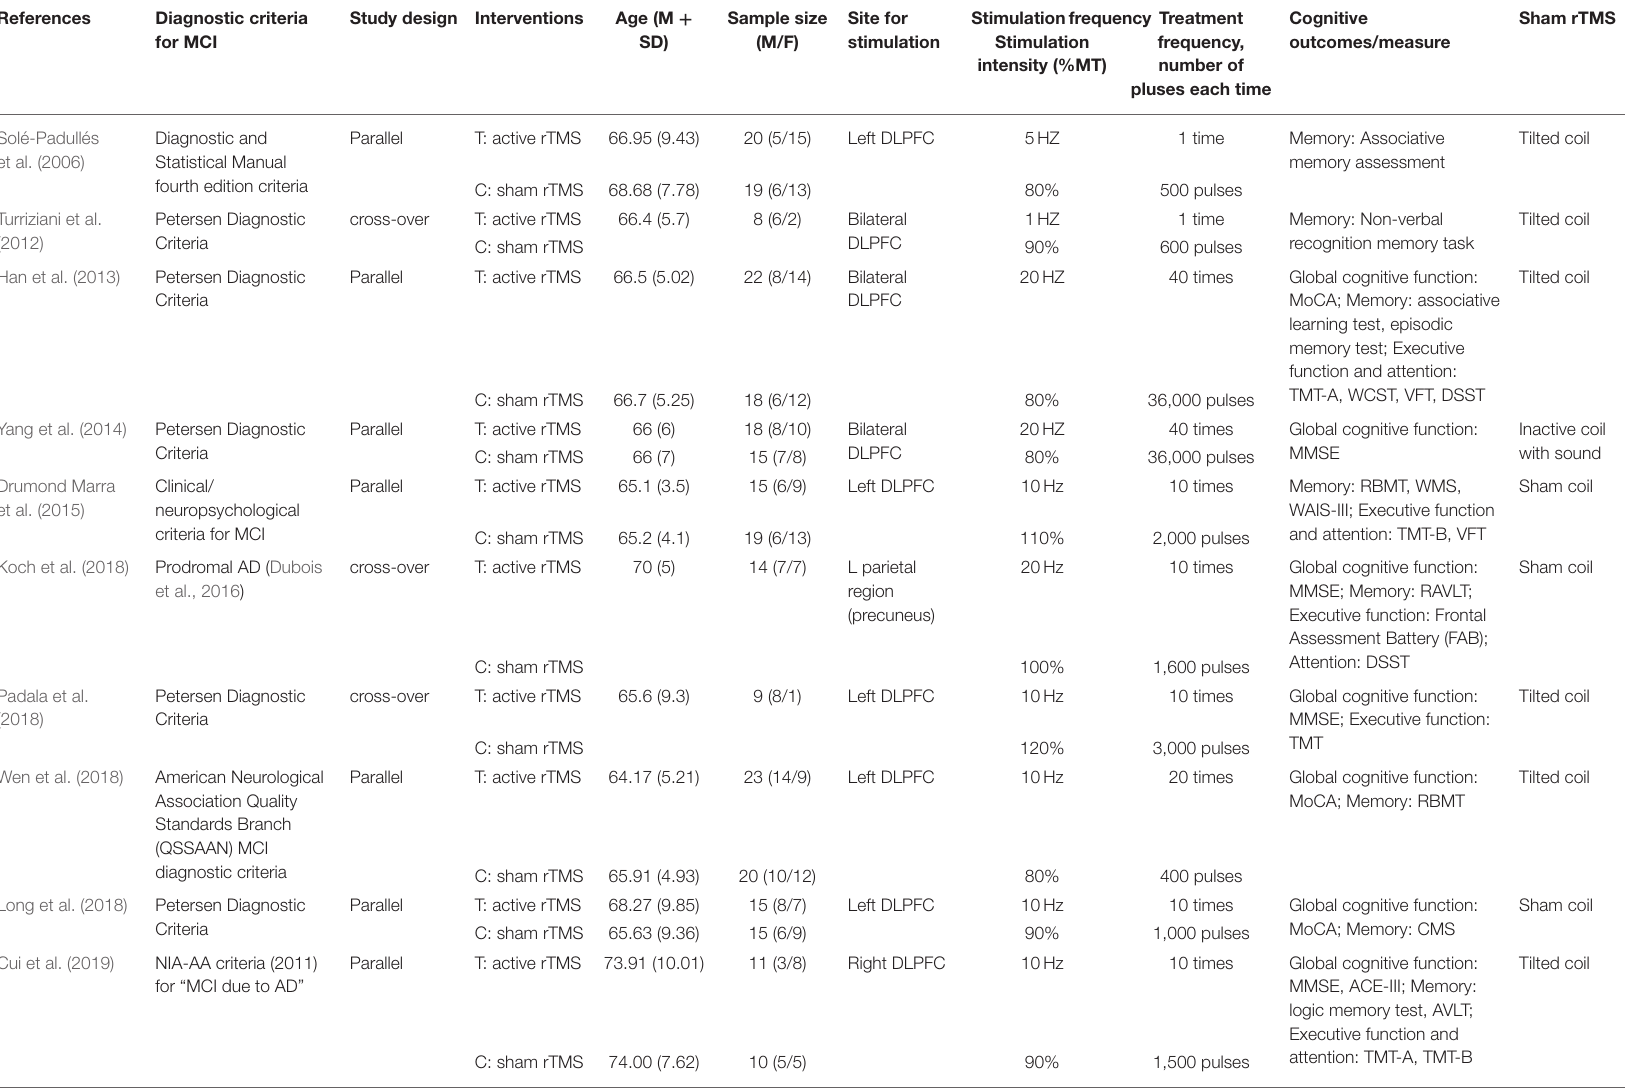
TABLE 1 | Characteristics of studies included in the